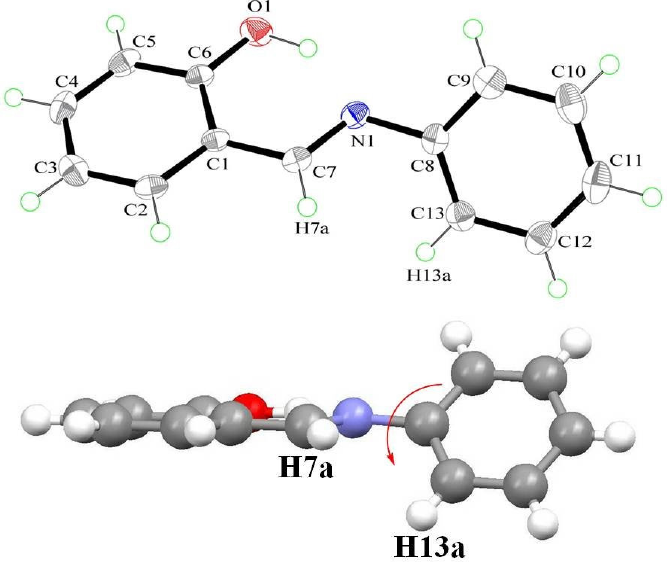
Figure 4. The molecular structure of 1 [75,76], showing the atom-labelling scheme. Displacement ellipsoids are drawn at the 50% probability